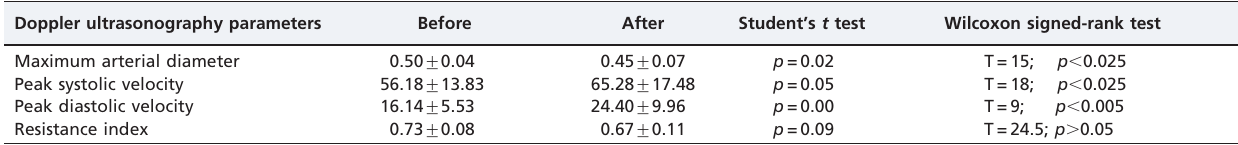
Table 1 - Doppler ultrasonography parameters (means ¡ standard deviation) before the lesion was created and after the placement of the covered stent and control arteriography with a perforating lesion model. Doppler ultrasonography